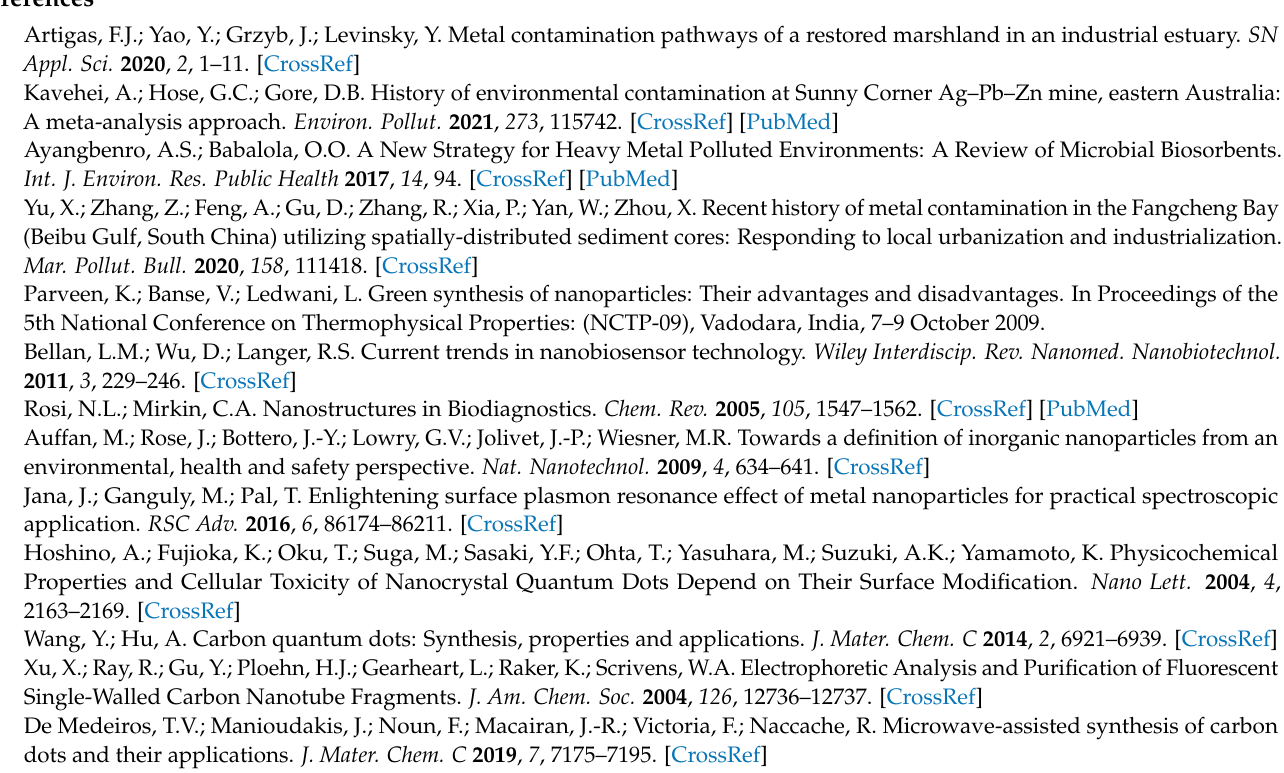
(A) Absorbance spectra for FG-CDs showing a new peak at ~475 nm in the presence of Pb 2+ . (B) Fluorescence spectra for FG-CDs in the presence of Pb 2+ . (C) The linear plot of the decreasing overall R/B area ratio showing a ~40% in red fluorescence with an r 2 = 0.98, Figure S5: (A) Stern-Volmer plot displaying the linear equation for FG-CDs and Hg 2+ with ksv = 2.14 × 10 − 4 and r 2 = 0.95 (B) Stern-Volmer plot displaying the linear equation for FG-CDs and Pb 2+ with ksv = 4.88 × 10 − 4 and r 2 = 0.94, Figure S6: R/B area ratio of FG-CDs with 1000 nM of various metallic cations showing comparison of quenching